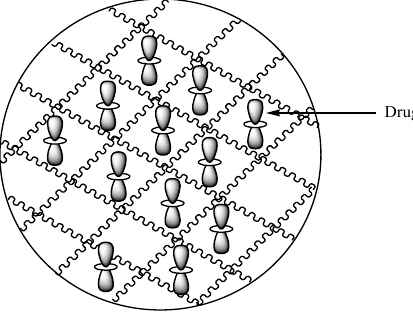
Figure 20. Schematic diagram showing hydrogels loaded with drugs.